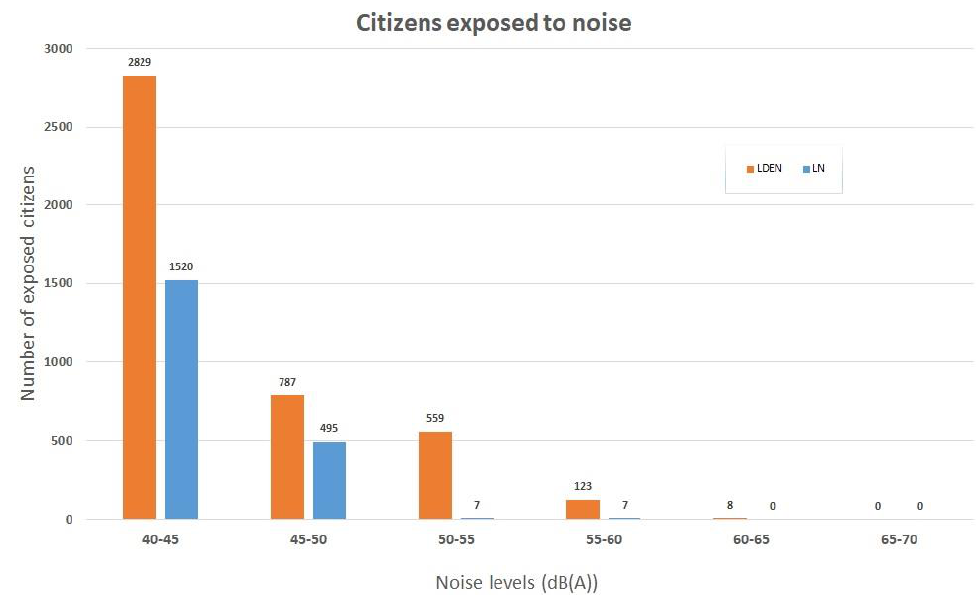
Figure 8. Number of citizens exposed to noise levels above 40 dB(A) L DEN or L N in Scenario 2.